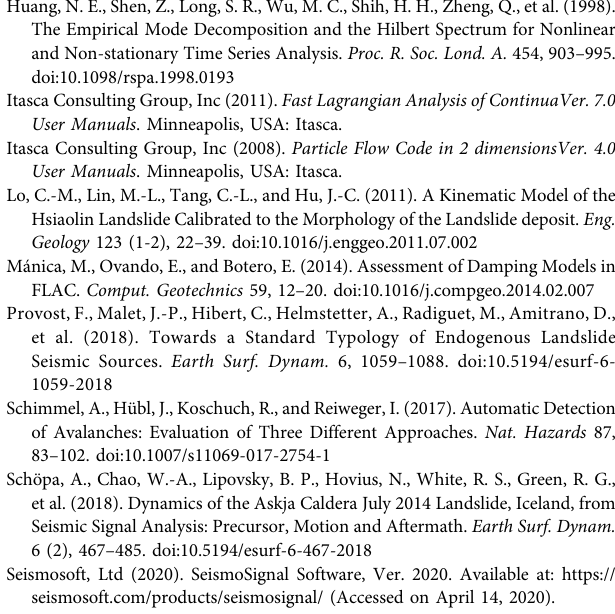
Supplementary Film SIM-3 | Numerical simulation for the rock mixture fall